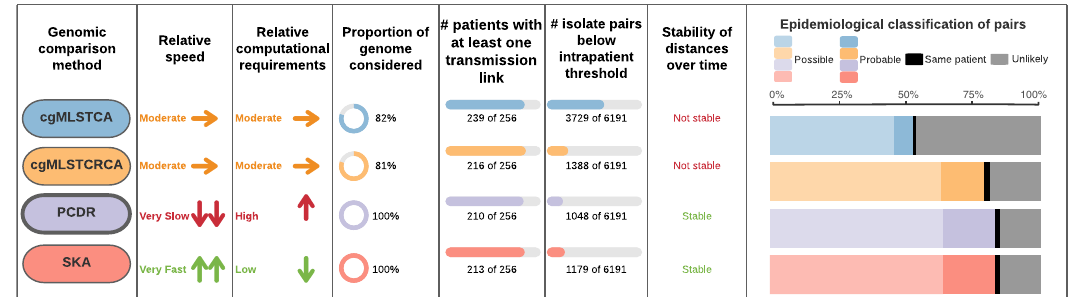
Fig. 3 Comparison of the major attributes of each of the methods used to determine genetic similarity. The number of isolate pairs below the intrapatient threshold was determined individually for each of the genomic methods and the epidemiological classi fi cation of isolate pairs only occurred for pairs below the threshold. The epidemiological classi fi cation process of the isolate pairs is detailed in the Supplementary Fig. 10. Pairwise comparison using de novo references (PCDR) was used as the gold standard genomic comparison